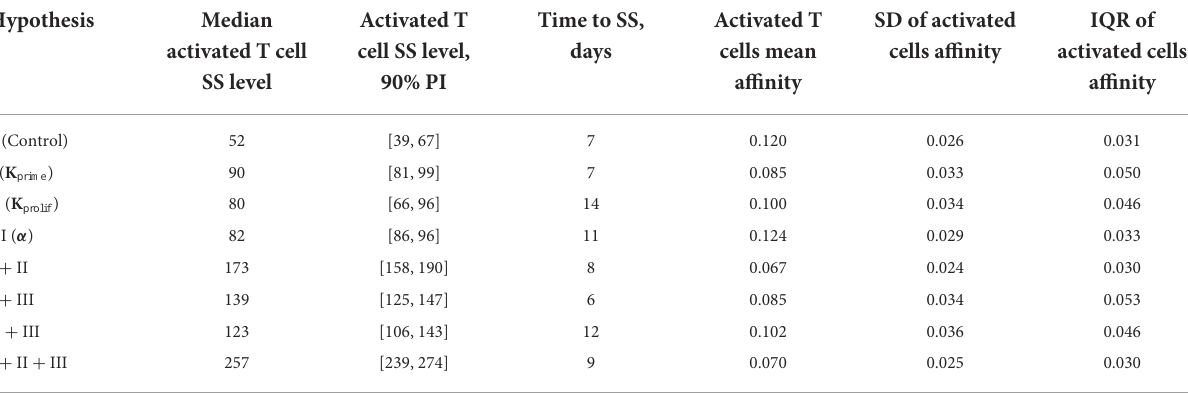
TABLE 1 Comparison of various anti CTLA-4 mechanism-of-action hypotheses and their possible combinations, in terms of activated T cell steady-state levels in LN and affinity distributions of activated lymphocytes leaving the lymph nodes. Hypothesis